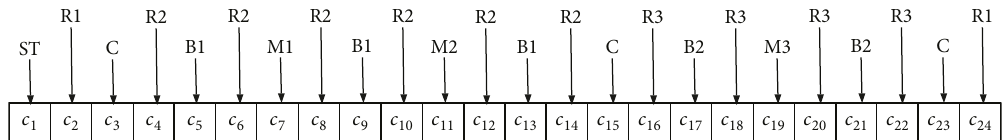
Figure 4: Linear array of cells representing the activities of the AMS of Figure 1.